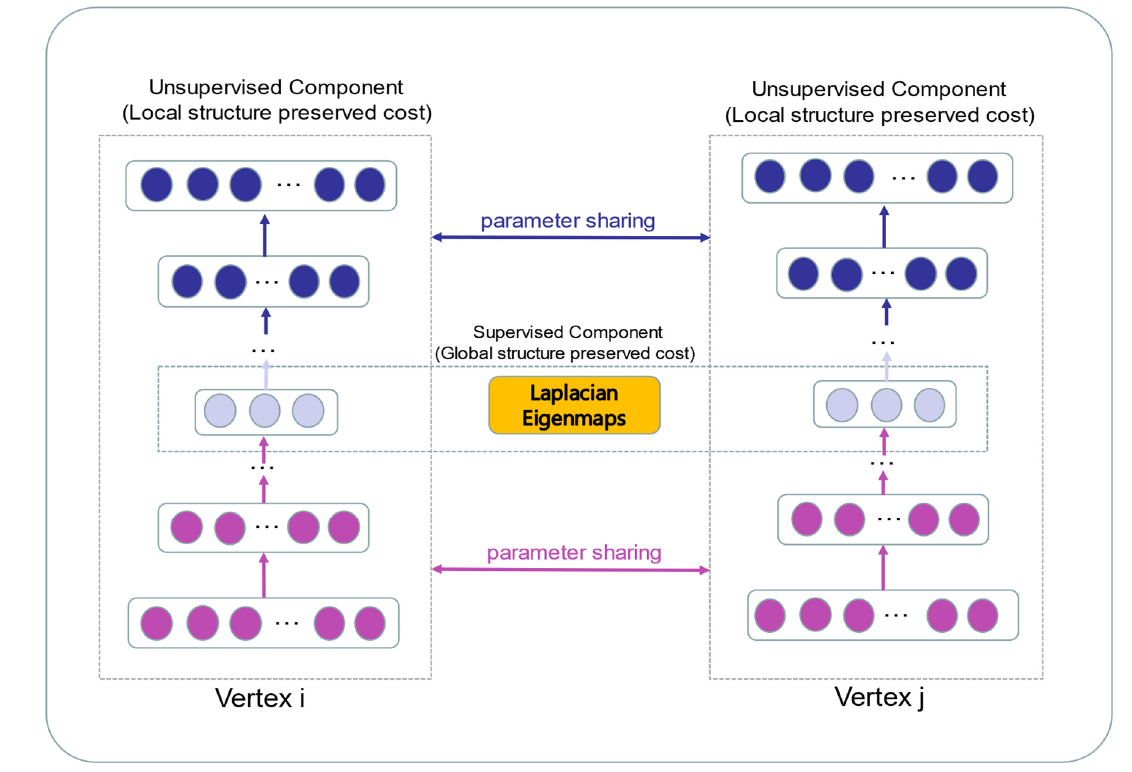
Figure 3. The schematic diagram of the SDNE framework.